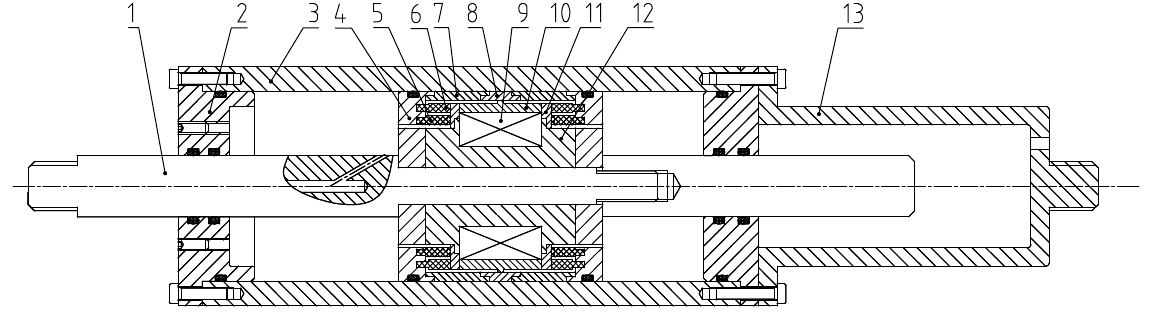
Figure 1. Schematic diagram of MR damper with bended magnetic circuit and folded flow gap. 1: Piston rod; 2: end cover; 3: cylinder; 4: piston cover; 5: small magnetic ring; 6: big magnetic ring; 7: magnetic sleeve; 8: nonmagnetic ring; 9: exciting coil; 10: magnetic semicircle; 11: nonmagnetic disk; 12: magnetic core; 13: end shield.